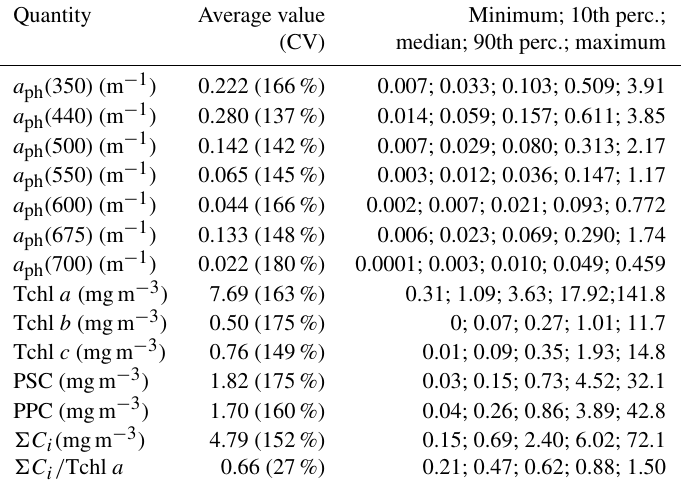
Table 2. Variability ranges of selected optical and biochemical quantities characterizing phytoplankton in samples from the Baltic Sea.